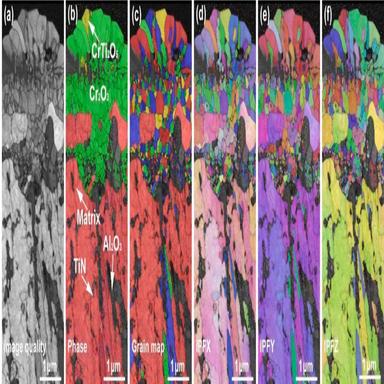
The on-axis TKD maps of the oxide scale of the Al8 CCA after 100 h oxidation at 800 ◦C in air: (a) Image quality image, (b) Phase image, (c) Grain map, (d) IPFX, (e) IPFY, and (f) IPFZ.